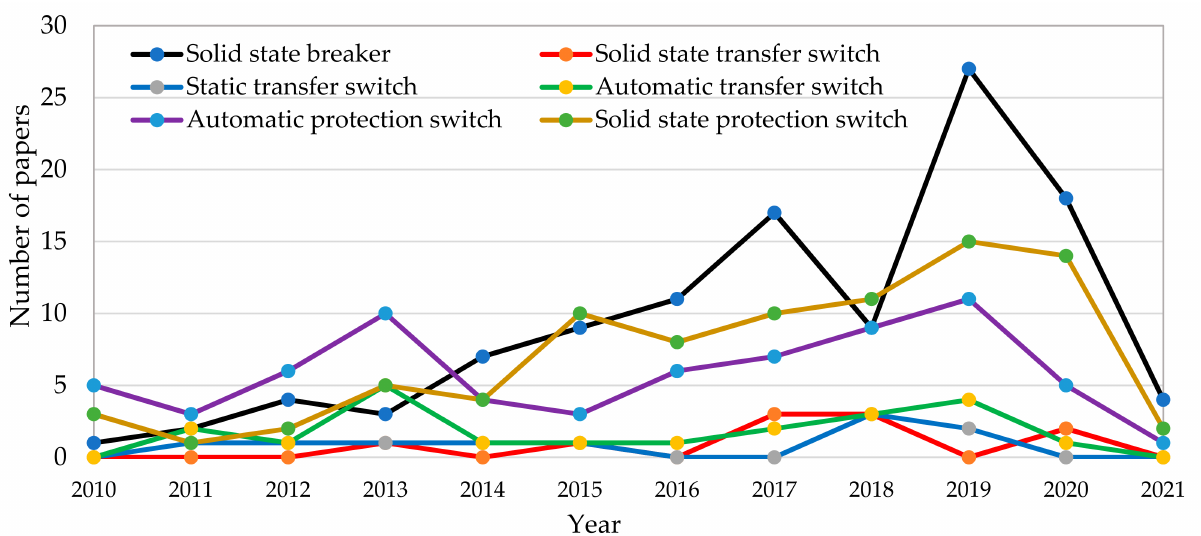
Figure 2. The number of papers per year in the research